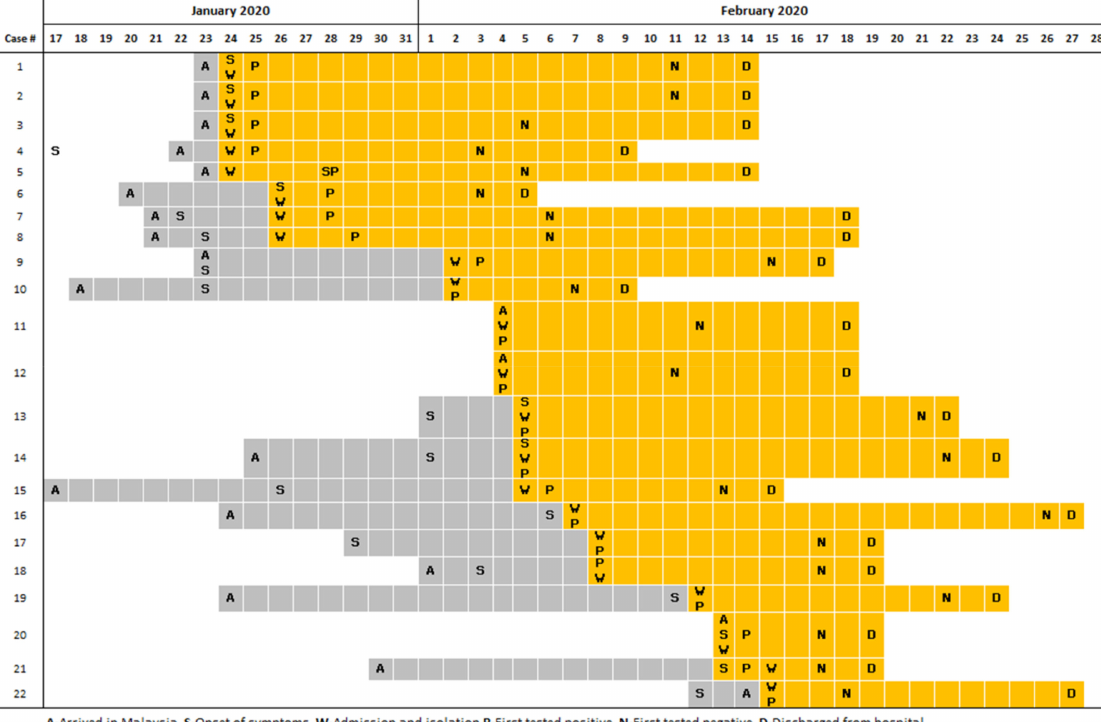
Figure 2. Timelines of the 22 cases in the first wave of COVID-19 infections in